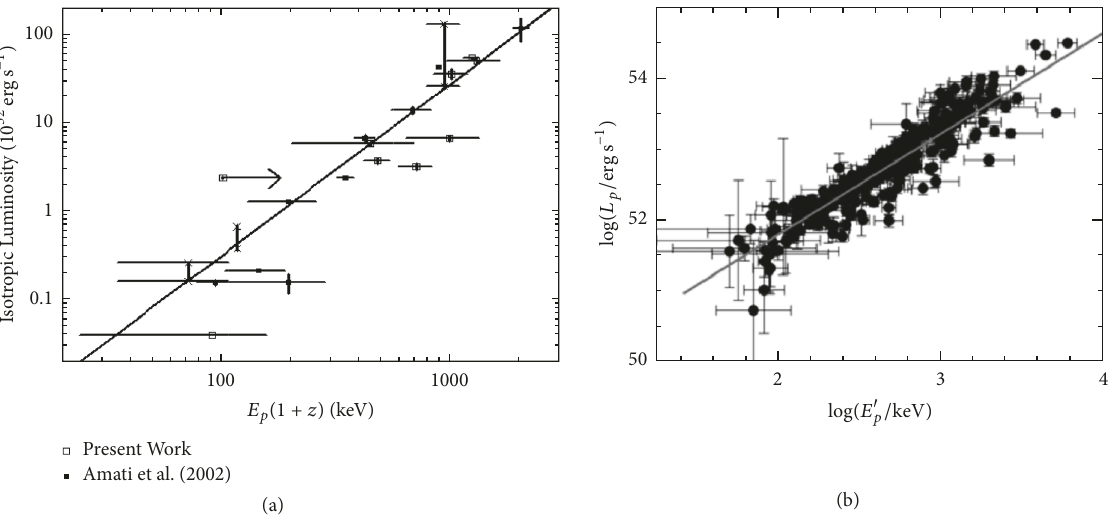
Figure 12: (a) The log 𝐿 -log 𝐸 relation. The open squares mark the BATSE data. BeppoSAX events, which are converted into the energy peak peak range of 30 – 10000 keV, are shown as filled squares and the cross points. The solid line indicates the best-fit line. (Figure after Yonetoku et al. [116]; see Figure 1 therein. @ AAS. Reproduced with permission.) (b) log 𝐿 pulses for the sample. The solid line stands for the best fit to the data. (Figure after Lu and Liang [230]; see Figure 4 therein. Copyright @ 2010